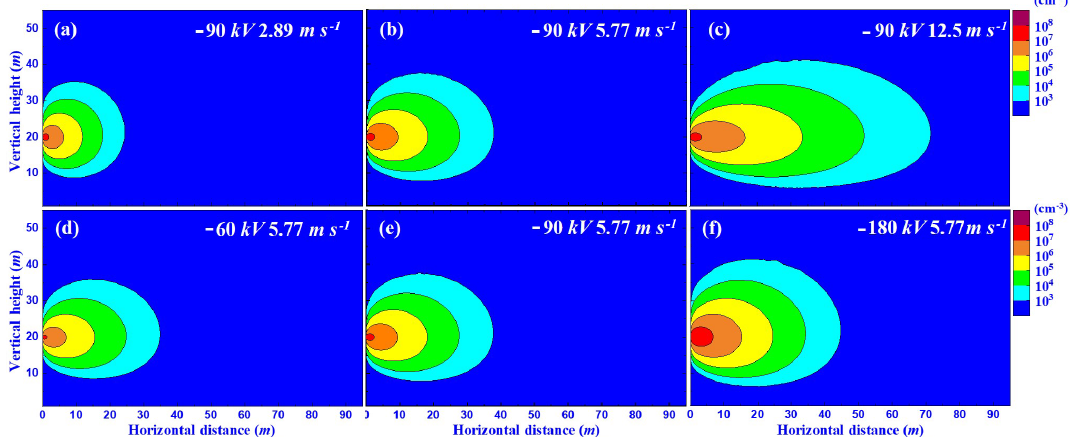
Figure 7. Increasing applied voltage and wind speed can enlarge the coverage area of the ion source. The effect of wind on the ion distribution in the field (numerical results) at (a) − 90kV and 2.89ms − 1 (wind speed), (b) − 90kV and 5.77ms − 1 , and (c) − 90kV and 12.5ms − 1 . The effect of wind on the ion distribution in the field (numerical results) at (d) − 60kV, (e) − 90kV and (f) −